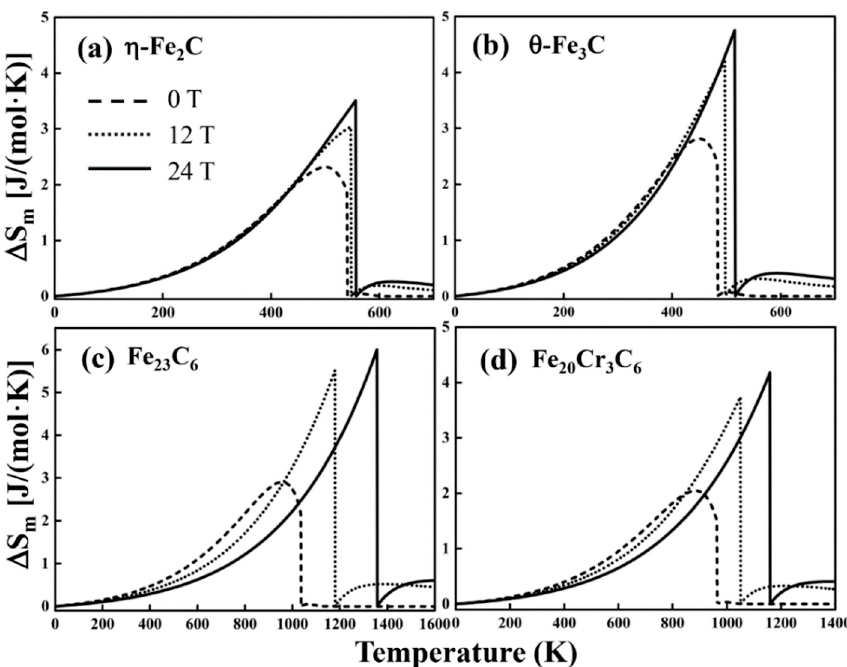
Figure 7. The magnetic-field-induced entropy changes of ( a ) η -Fe 2 C, ( b ) θ -Fe 3 C, ( c ) Fe 23 C 6 and ( d ) Fe 20 Cr 3 C 6 with and without a magnetic field.